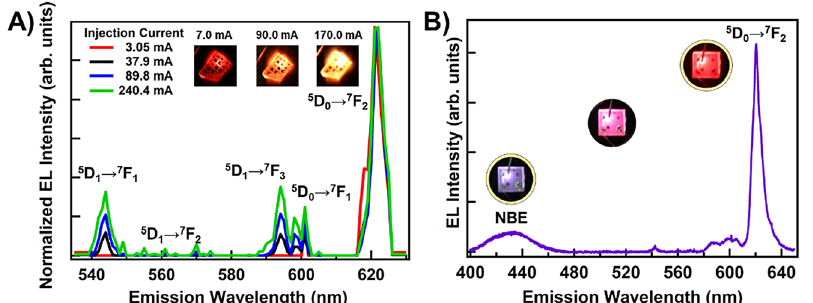
Figure 9: (A) Normalized electroluminescence (EL) spectra from a Eu-doped GaN LED. At low currents, the emission from the 5 D 1 state is negligible and the emission is dominated by the emission from the 5 D 0 state. The inset shows an image of the LED under different injection currents.(B)ELspectrafromaEu-dopedGaNLEDthatwascodopedwithSiandMg.TheemissionfromthisLEDisprimarilyamixtureofredand blue emission, where the blue and red emission is due to Si/Mg related levels and the 5 D 0 state of the Eu 3 + ions, respectively. [Reprinted (adapted) with permission from a study by Mitchell et al. [22]. Copyright 2019, American Chemical